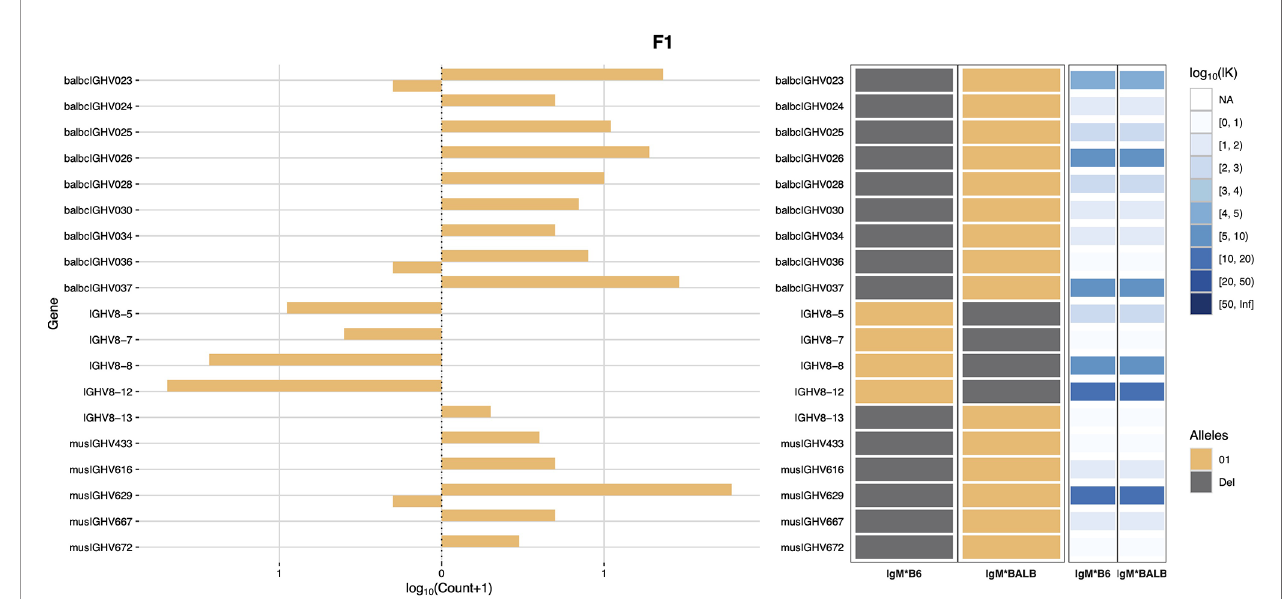
FIGURE 1 | IGHV8 subgroup haplotype plots for BALB/c and C57BL/6. The C57BL/6 chromosome is shown as IgM*B6 and the BALB/c chromosome as IgM*BALB.